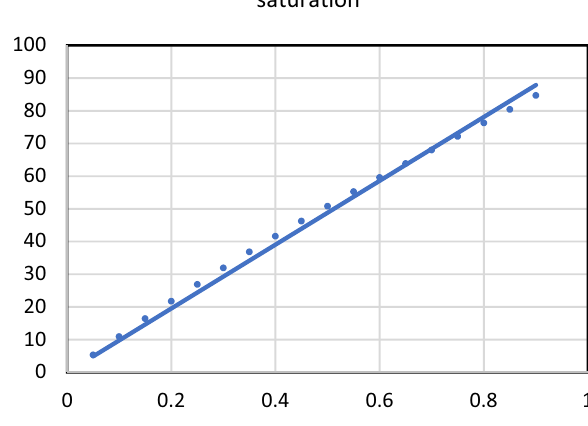
Fig. 28 Hydrocarbon saturation from density